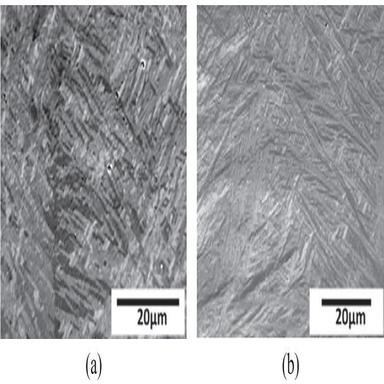
Microstructural morphology composed of fine alpha plates. (a) KF3 sample in the build direction showing columnar grain boundaries and α-plates. (b) Fractal mesh sample showing fine α-plates.